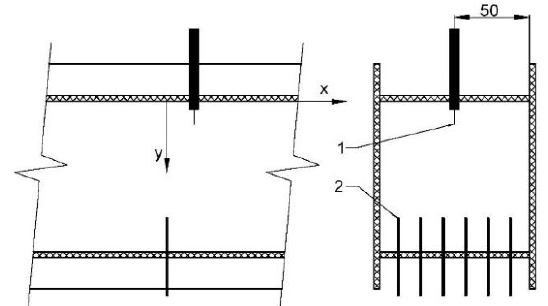
Fig. 3. Measuring area for velocity measurement. 1 sensor HWA, 2 thermocouples.